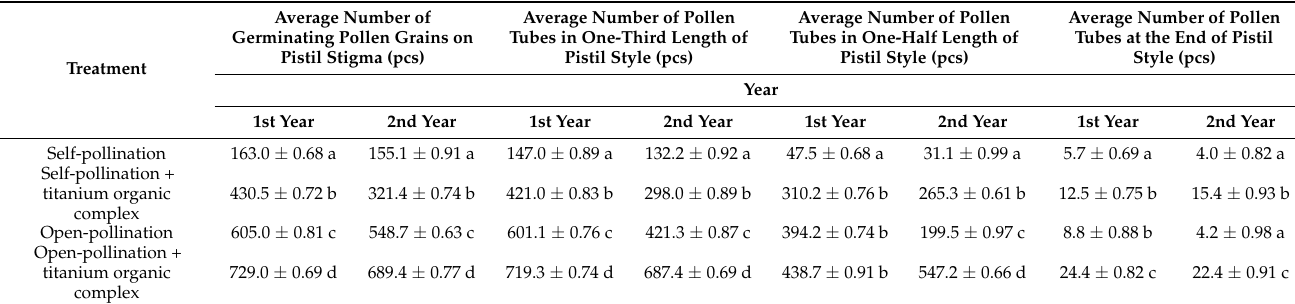
Table 1. The effect of titanium organic complex application on number of pollen grains germinating on pistil stigma and number of pollen tubes growing through pistil style (pieces).